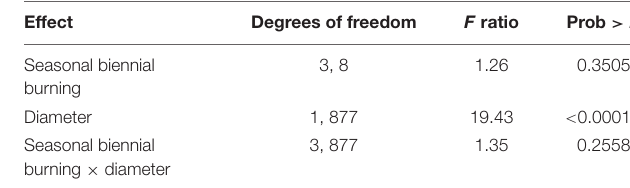
TABLE 2 | Results of a generalized linear mixed-effects analysis of variance (ANOVA) for the effects of seasonal biennial burning (winter, spring, summer) and the unburned treatment, diameter, the interaction between seasonal biennial burning and diameter on the odds of survival for individual longleaf